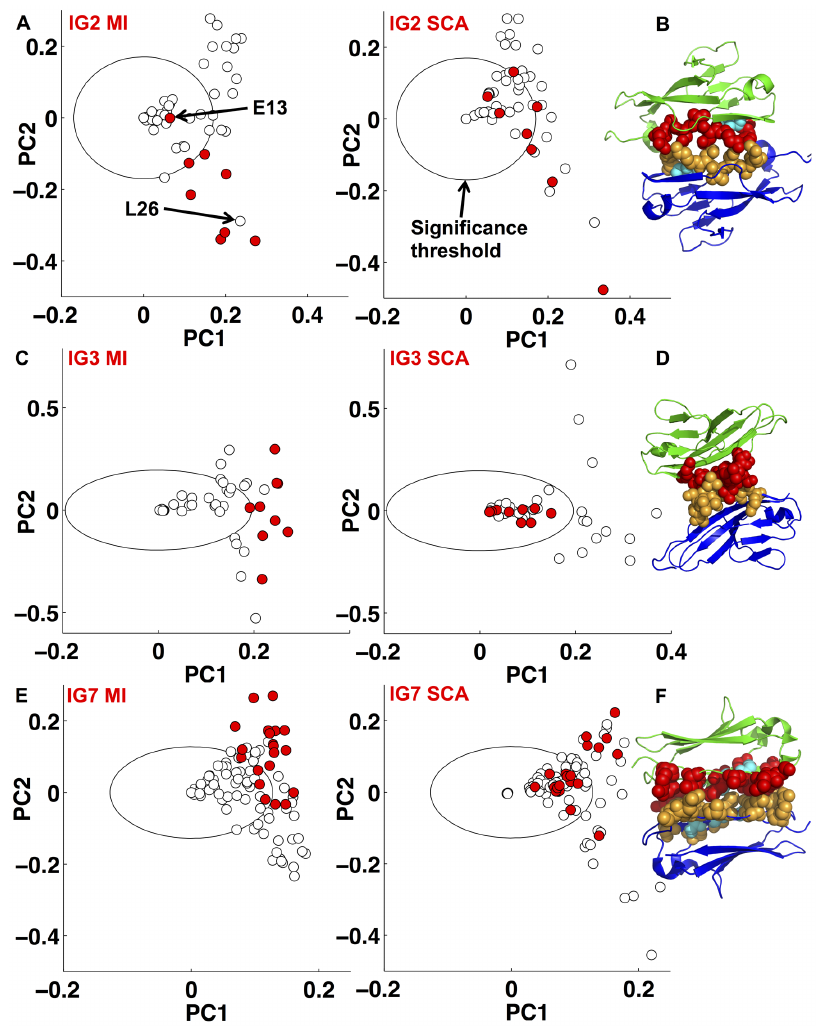
Figure 4. A) PCA of the correlation matrix produced by (left) MI (weighting function w var and MI ) applied to the Dscam A) Ig2 C) Ig3, and E) Ig7 domain alignments. The plots produced by MI analysis in each of function w cons and SCA ij A, C and E largely recover the experimentally verified residues (red) identified in [24,25]. B), D), F) Experimentally verified residues (red in monomer one, and orange in monomer two) mapped onto the corresponding domain dimer interface from crystal structure 3DMK [26]. Those